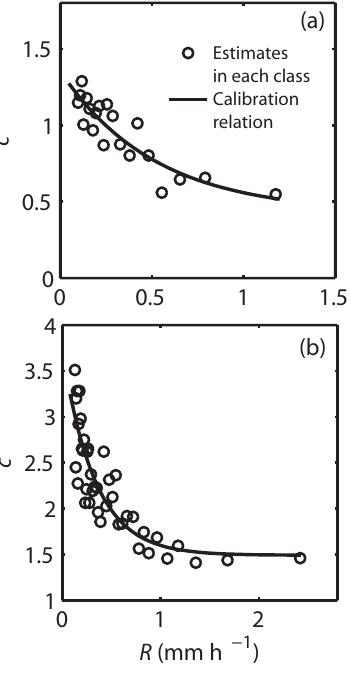
Fig. 5. Calibration relations in Eq. (1) between the STRAIN model parameter c and the coarse-scale mean precipitation intensity R for application in the (a) time and (b) space–time domains.